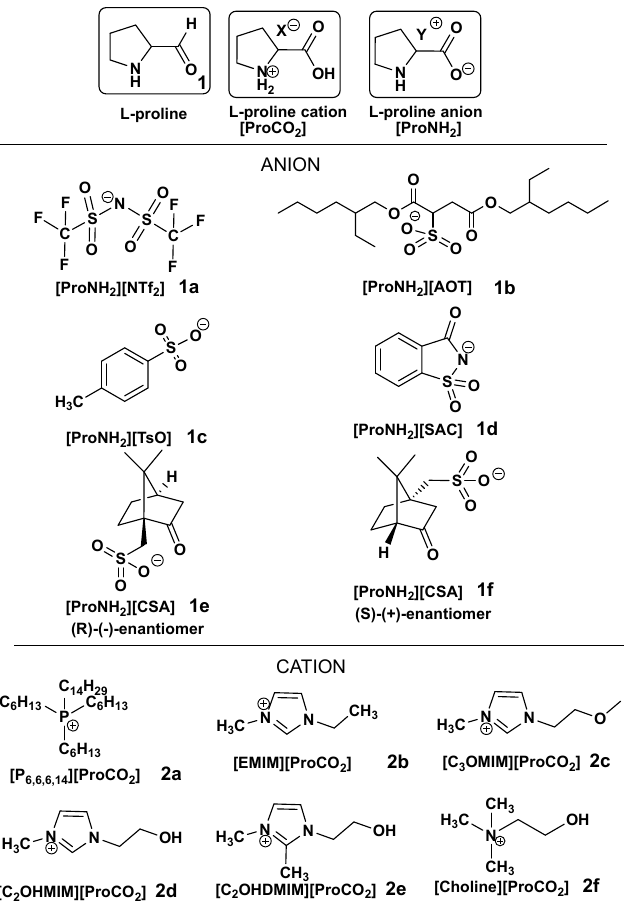
Figure 1. Structures of chiral salts developed from L-proline .